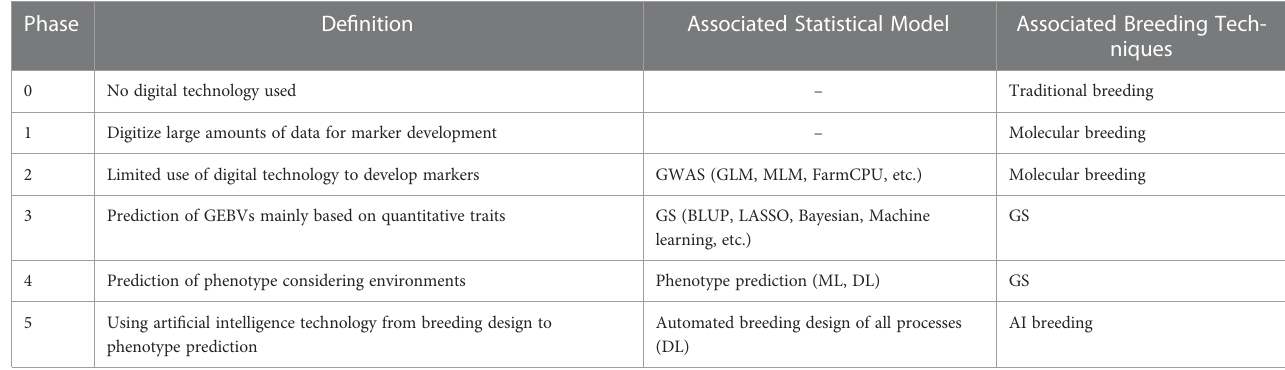
TABLE 4 Phases of digital breeding de fi ned in the current review.